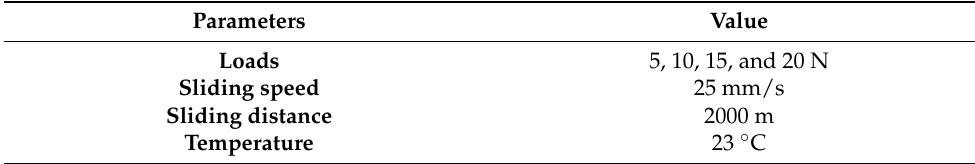
Table 1. Pin-on-disk test